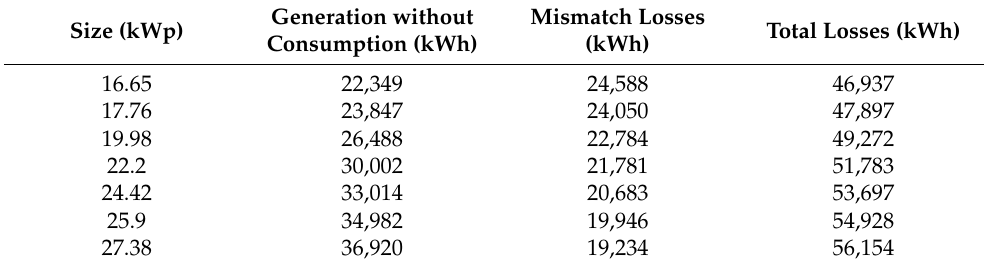
Figure 10. Hourly profile of 1 August (assumed PV system size of 25.9 kWp). Table 5. Losses